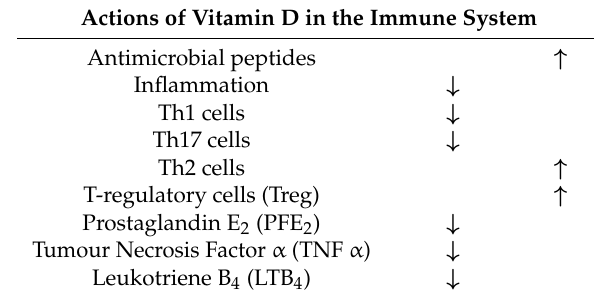
Table 1. Actions of vitamin D in the immune system that may influence pain management [1,2,6,24,29]. Actions of Vitamin D in the Immune